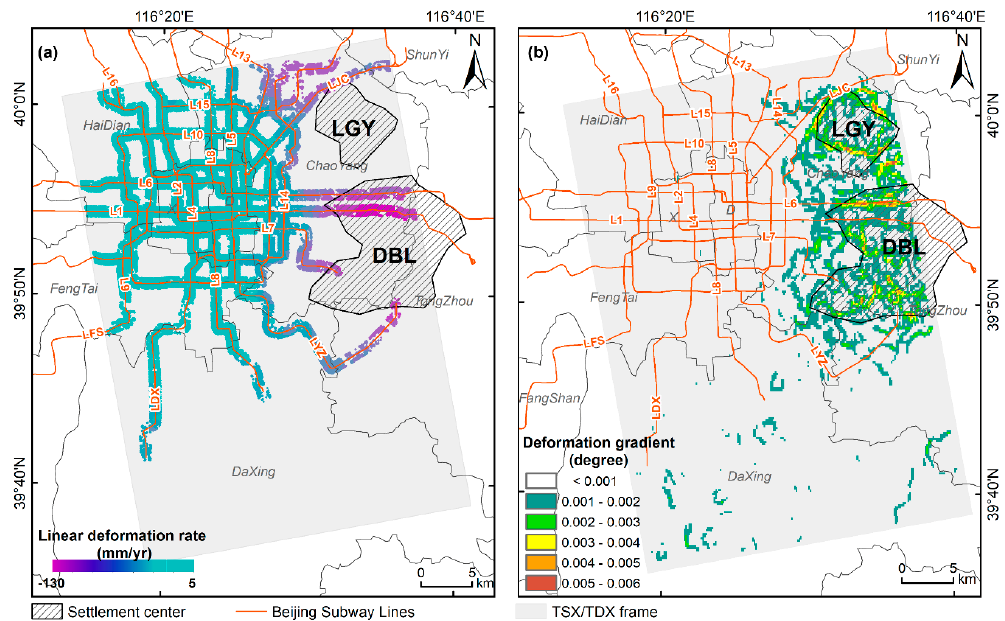
Figure 5. The left map shows the average deformation rate of the Beijing Subway Network (within a 500-meter buffer zone), and the right map shows the deformation gradient.